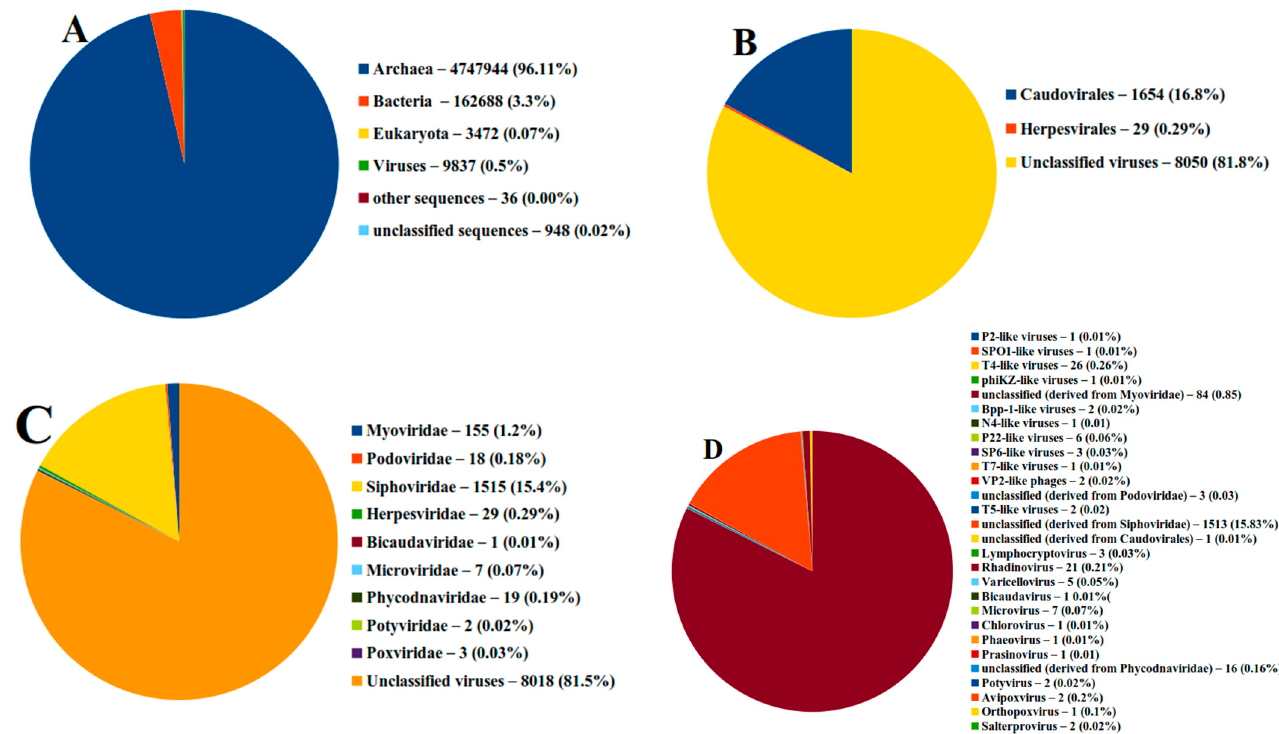
Figure 2. The distribution of viromes in brine sample according to ( A ) domain, ( B ) order, ( C ) family, ( D ) genus. The sequences were analyzed using MG-RAST. Table 1. Genome and capsid described of family’s virus in brine sample.